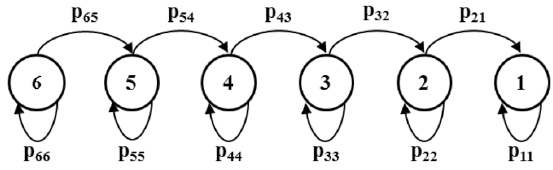
Fig. 4. Markov process for building deterioration